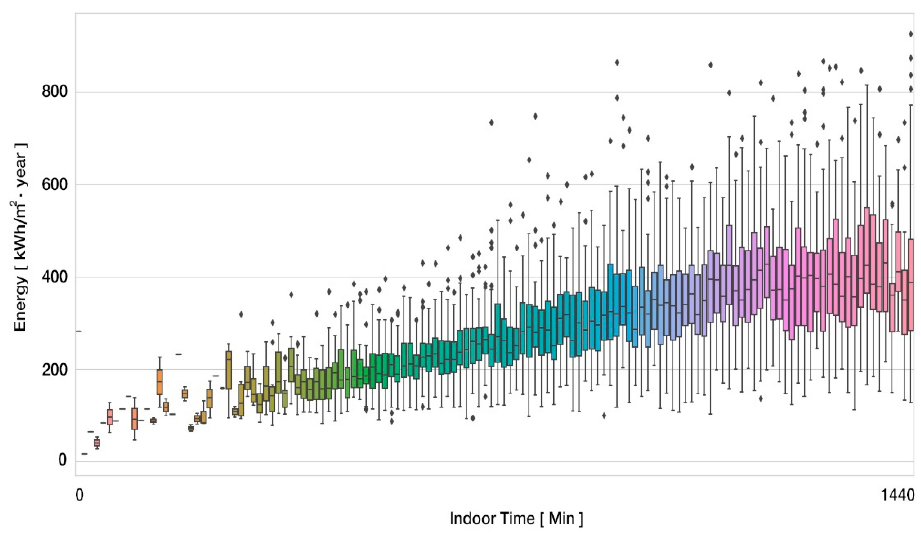
Figure 13. Comparison of energy consumption according to time spent indoors